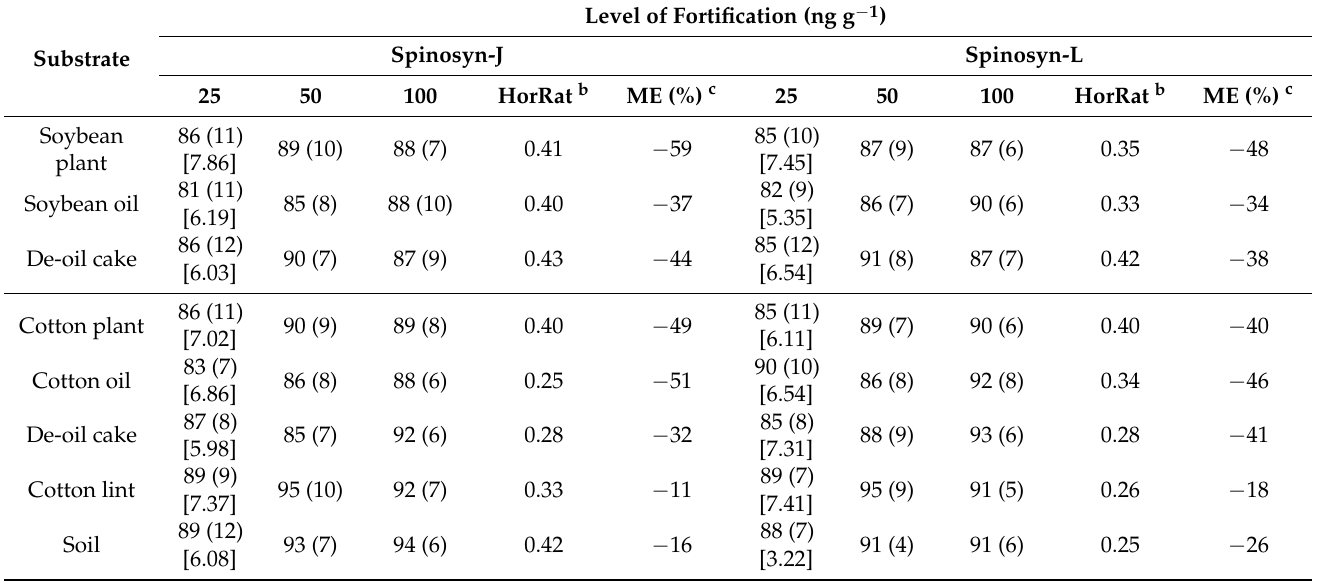
Table 2. Recovery % (RSD) a , expanded uncertainty (%) at 25 ng g − 1 , HorRat and matrix effect of test